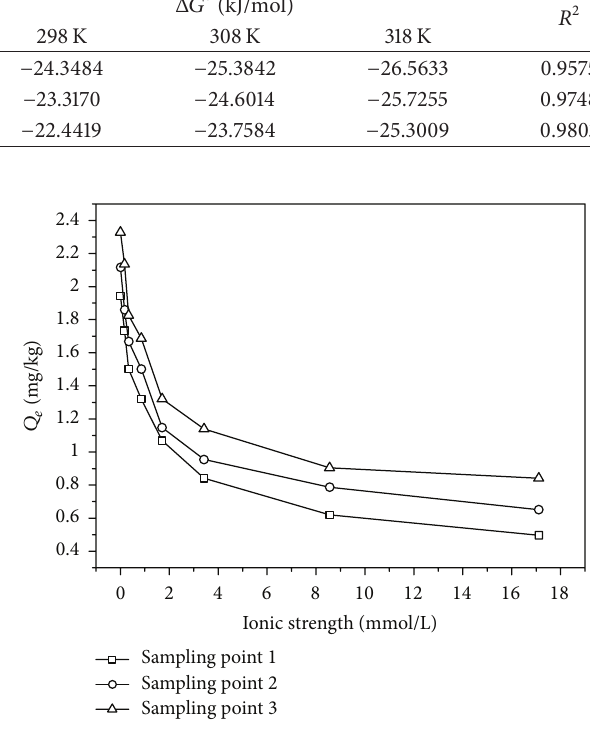
Figure 9: Effect of ionic strength on OTC adsorption onto sediment